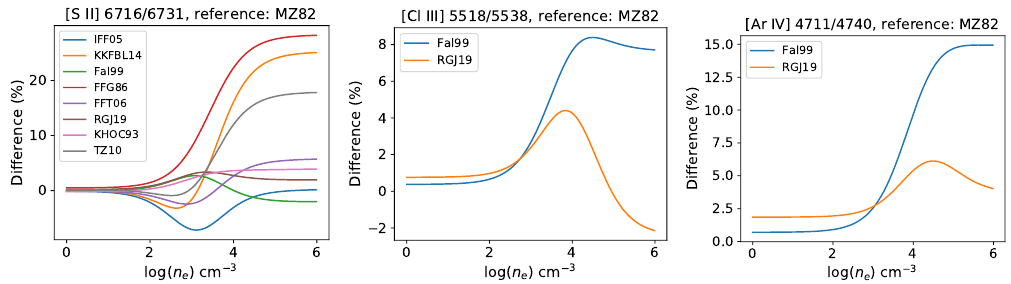
− 4 S o ) / ε ( 2 D o − 4 S o ) density-sensitive emissivity ratio of 5/2 3/2 3/2 3/2